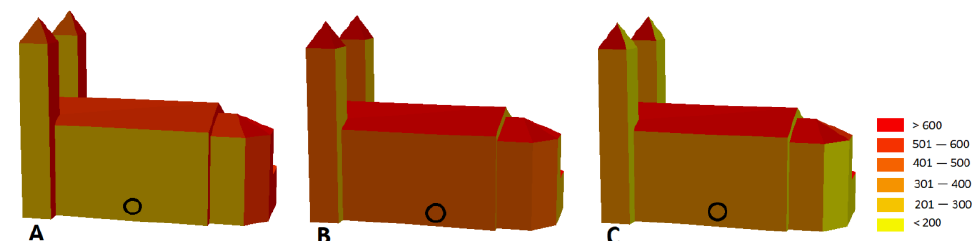
Figure 10. Solar irradiance at Greek Church on 23 June 2021 (W/m 2 ) at ( A ) 8:50 a.m., ( B ) 11:44 a.m., and ( C ) 3:25 p.m. The black circle represents the measurement location. Table 5. Solar irradiance at Greek-Catholic Church in W/m 2 on 23 June 2021. Time Pyranometer v.sun